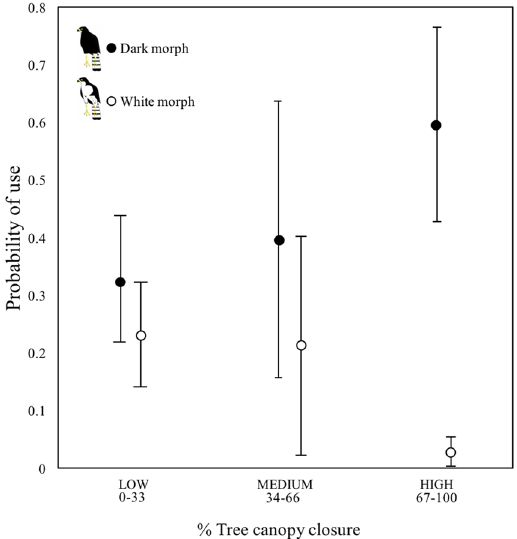
Figure 4. Probability of use ( ± 1 SE) of areas with different canopy cover levels (percentage of canopy closure) by male black sparrowhawk morphs on the Cape Peninsula. Dark morph males had a significantly higher probability of using high tree cover (67–100% canopy cover) compared to white morphs ( χ 2 1 = 11.71, P < 0.001)). No significant differences in selection were found for low (0-33%) ( χ 2 1 = 3.13, P = 0.07) or medium (34-66%) canopy cover ( χ 2 1 = 0.27, P =